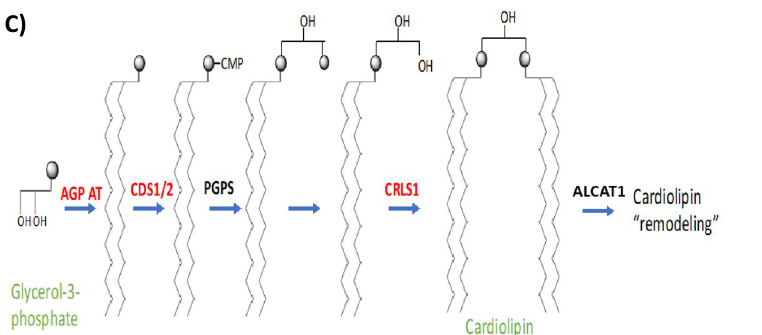
Figure 1. Genes related to mitochondrial electron transport chain (ETC) function and cardiolipin (CL) biosynthesis are significantly over-represented and differentially regulated in cytoglobin (LST421) expressing cells compared to non-cytoglobin expressing cells (NCE). ( A) Multiple subunits of the electron transport chain complex were shown to be up-regulated: 13 in complex I, 2 in complex II, 5 in complex III and 4 in complex IV in cytoglobin expressing cells (highlighted in green). Downregulations in gene expression also occurred (highlighted in red): Complex I contained 3 genes, Complex III contained 1 and Complex IV contained 1 gene downregulated in cytoglobin expressing cells. ( B) Biosynthesis of cardiolipin from glycerol 3-phosphate, 1-acylglycerol-3-phosphate O-acyl transferase 3 (AGP AT), CDP-diacylglycerol synthases 1 and 2 (CDS1/2), cardiolipin synthase (CRLS1) and lysocardiolipin acyltransferase 1 (LCLAT1), all genes involved in the biosynthesis and re-modelling of mitochondrial cardiolipin lipids were transcriptionally down-regulated in cytoglobin expressing cells (highlighted in red). There was no change in expression of phosphatidylglycerol phosphate synthase (PGPS) and phosphatidylglycerol-phosphate phosphatase (PGPP) was not included in the